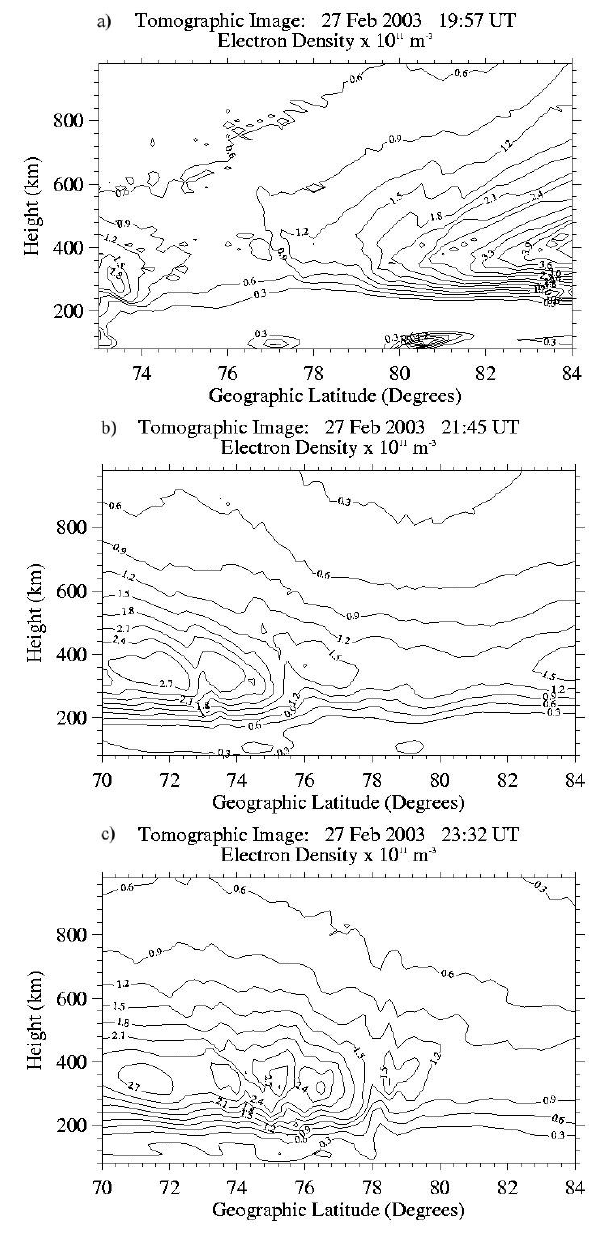
Fig. 5. Electron density tomographic images showing how the au- roral oval expanded from (a) north of the FPIs’ field-of-view at 19:57 UT to (b) to south of 77 ◦ N at 23:45 UT and then by (c) 23:32 UT retreating slightly poleward.